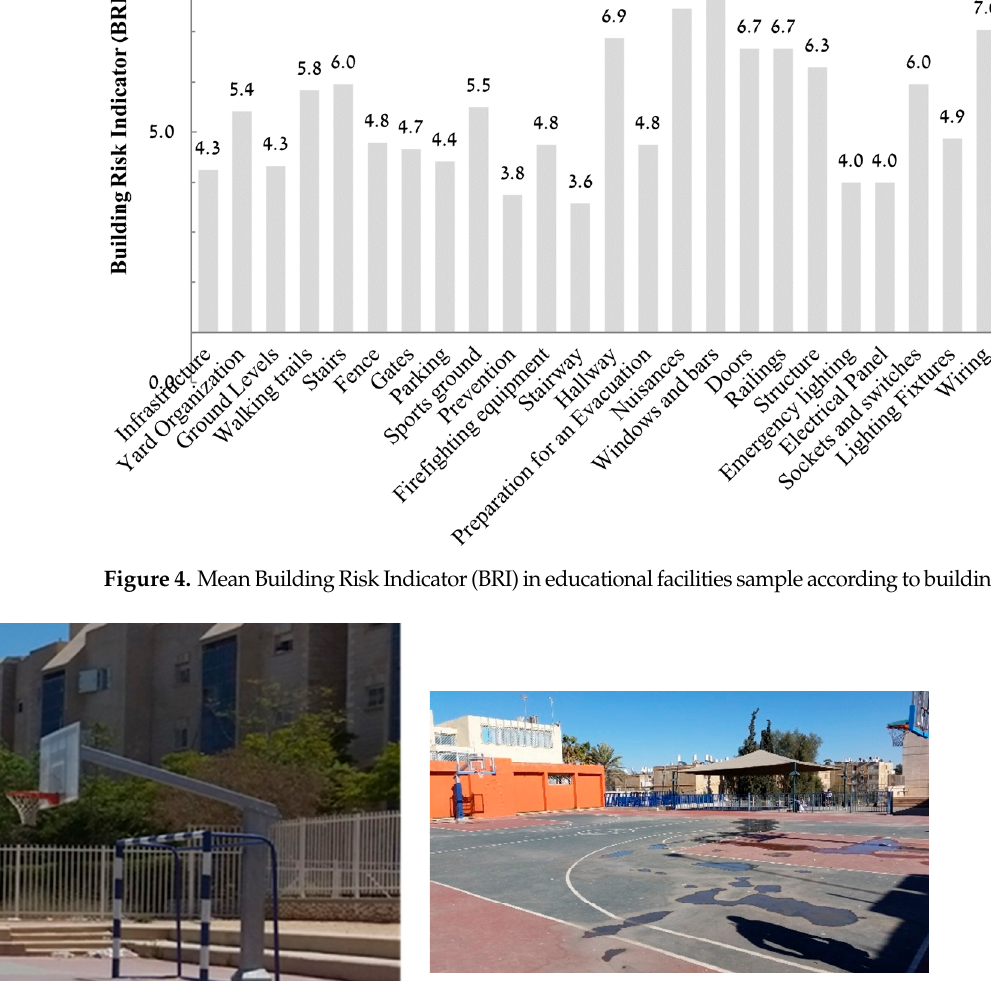
Figure 6. ( a ) Deteriorated exterior stone cladding. ( b ) Cracked stone